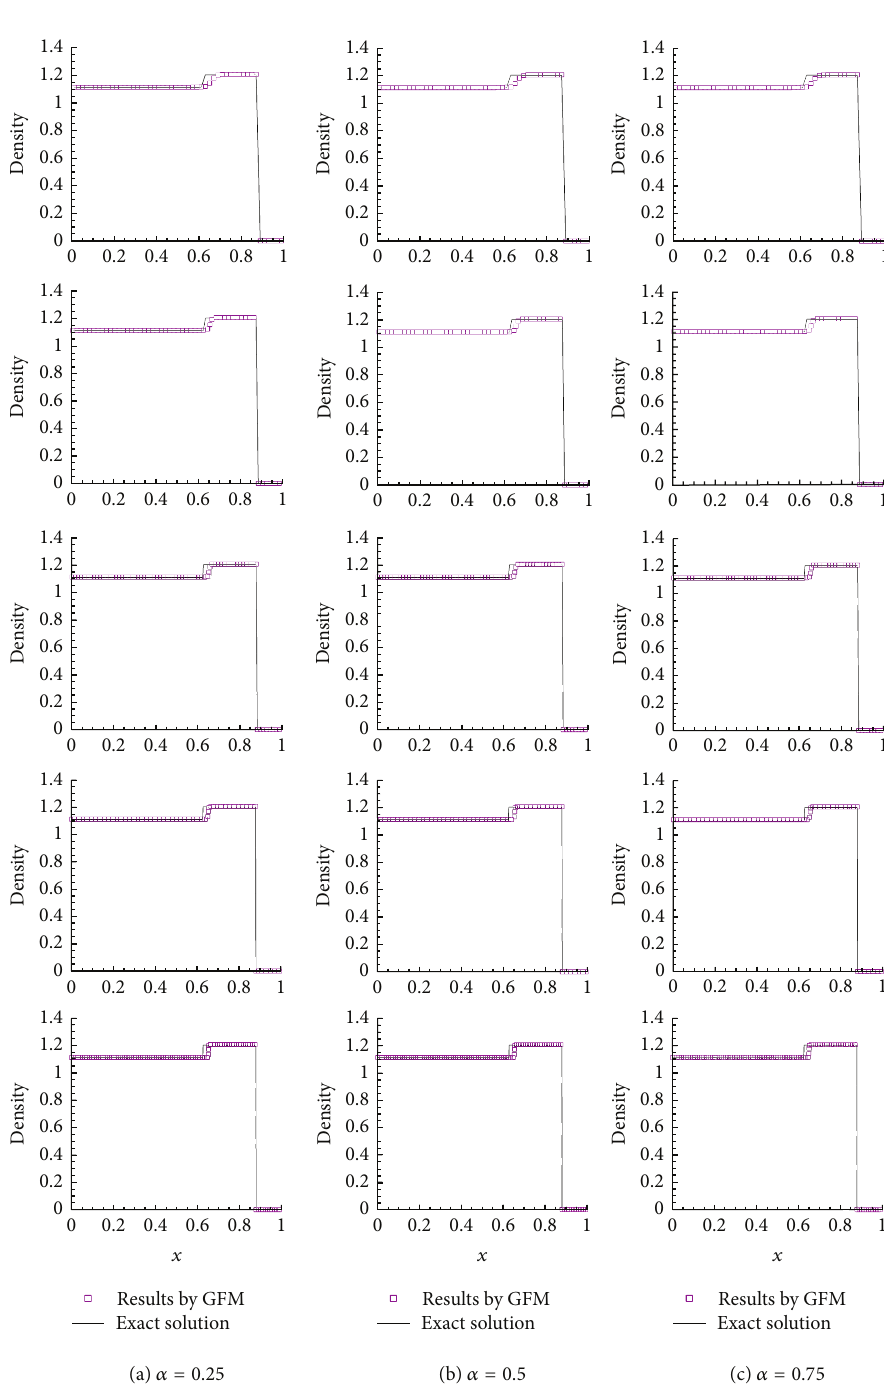
Figure 6: Comparisons between numerical results and exact solution, first line: Δ𝑥 = 1/50 , second line: Δ𝑥 = 1/100 , third line: Δ𝑥 = 1/200 , fourth line: Δ𝑥 = 1/400 , and fifth line: Δ𝑥 = 1/800 (Case